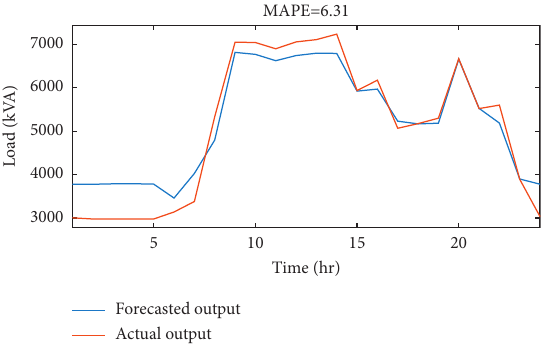
Figure 17: The Fuzzy-PSO prediction of Mewulid load.